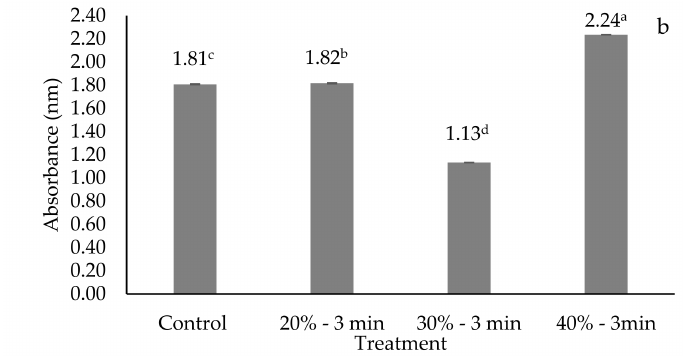
Figure 6. Effect of ultrasound (20 kHz) on the proteolysis of L. acidophilus ( a ) and L. helveticus ( b ). a,b,c,d Different literals in column indicate significant differences between treatments ( p < 0.05).